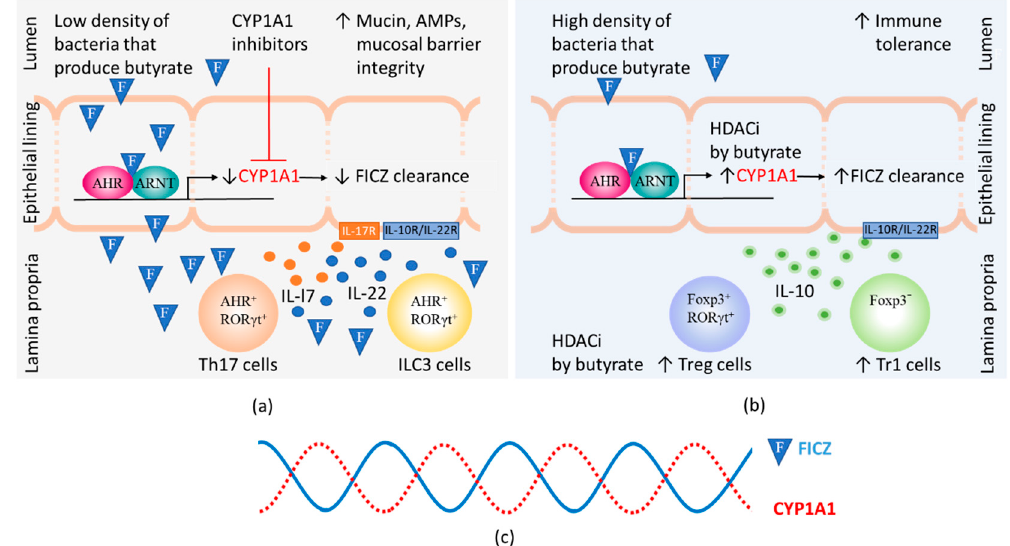
Figure 3. The steady-state levels of 6-formylindolo[3,2- b ]carbazole (FICZ) influences gut immunity. The amount of FICZ (illustrated by an F in a blue triangle) that reaches the lamina propria depends on the CYP1A1 activity in the epithelial lining, which is modified by the presence of CYP1A1 inhibitors. Butyrate can by virtue of its histone deacetylase inhibitory function (HDACi) contribute to increased numbers of Foxp3 positive and negative regulatory T cells (Treg and Tr1 cells) as well as increased CYP1A1 expression in intestinal epithelial cells. ( a ) At low levels of butyrate, heightened immunity is promoted by CYP1A1 inhibitors that cause FICZ to reach lamina propria and stimulate IL-22 and IL-17 expression in Th17 and ILC3 cells. Binding of IL-17 and IL-22 to their receptors on epithelial cells stimulate increased production of mucins and antimicrobial peptides (AMPs); ( b ) At high levels of butyrate, high CYP1A1 activity promotes the clearance of FICZ. Immunity is suppressed and Treg and Tr1 cells produce IL-10 that helps maintain tolerance to commensal bacteria by binding to receptors on epithelial cells; ( c ) Daily 24 h cycles in the CYP1A1 activity and the levels of FICZ.